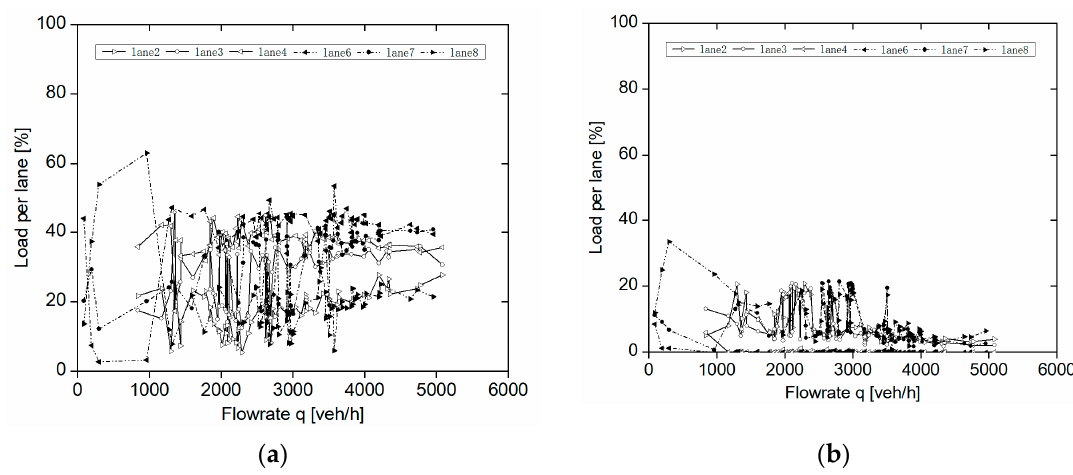
Figure 4. ( a ) Car load per lane versus flow rate; ( b ) Truck load per lane versus flow rate.